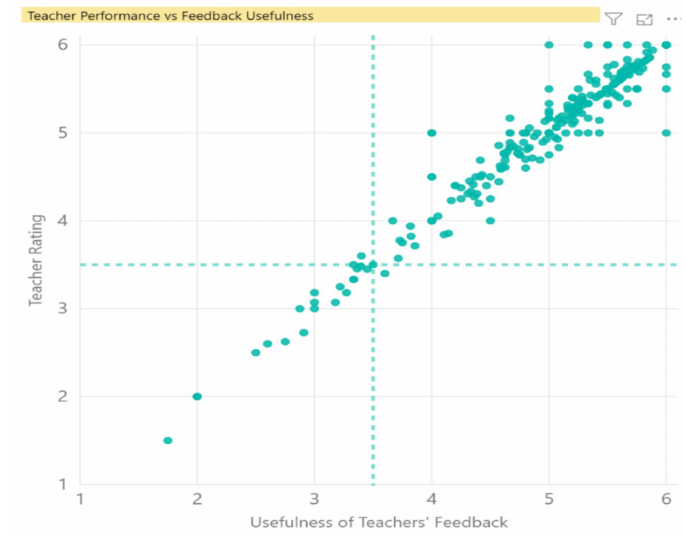
Figure 14. Feedback Usefulness vs. Teacher Rating. Note: (1) In the visual, each data point represents the average rating given by students to a teacher, the question “The teacher provided me with a helpful feedback” for a particular course.